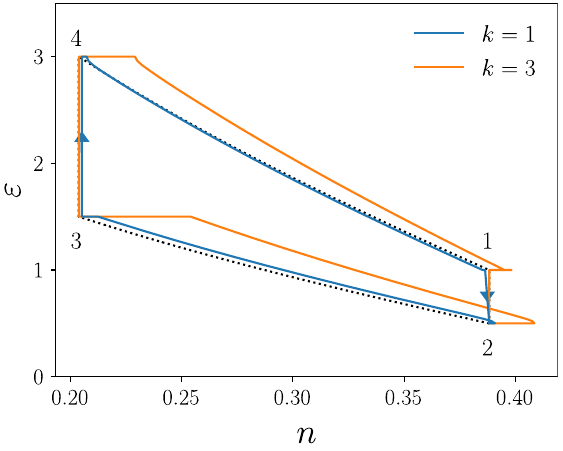
FIG. 12. Carnot cycle for the RL model showing the level ’ s energy ε ð t Þ versus its occupation n ð t Þ . For finite system-bath interaction strengths (blue and orange solid lines), correlations with the bath lead the system state during the isotherms to deviate significantly from equilibrium (dotted line). The protocol is the 25 same as Fig. 13(a) with g 2 0 τ weak on ¼